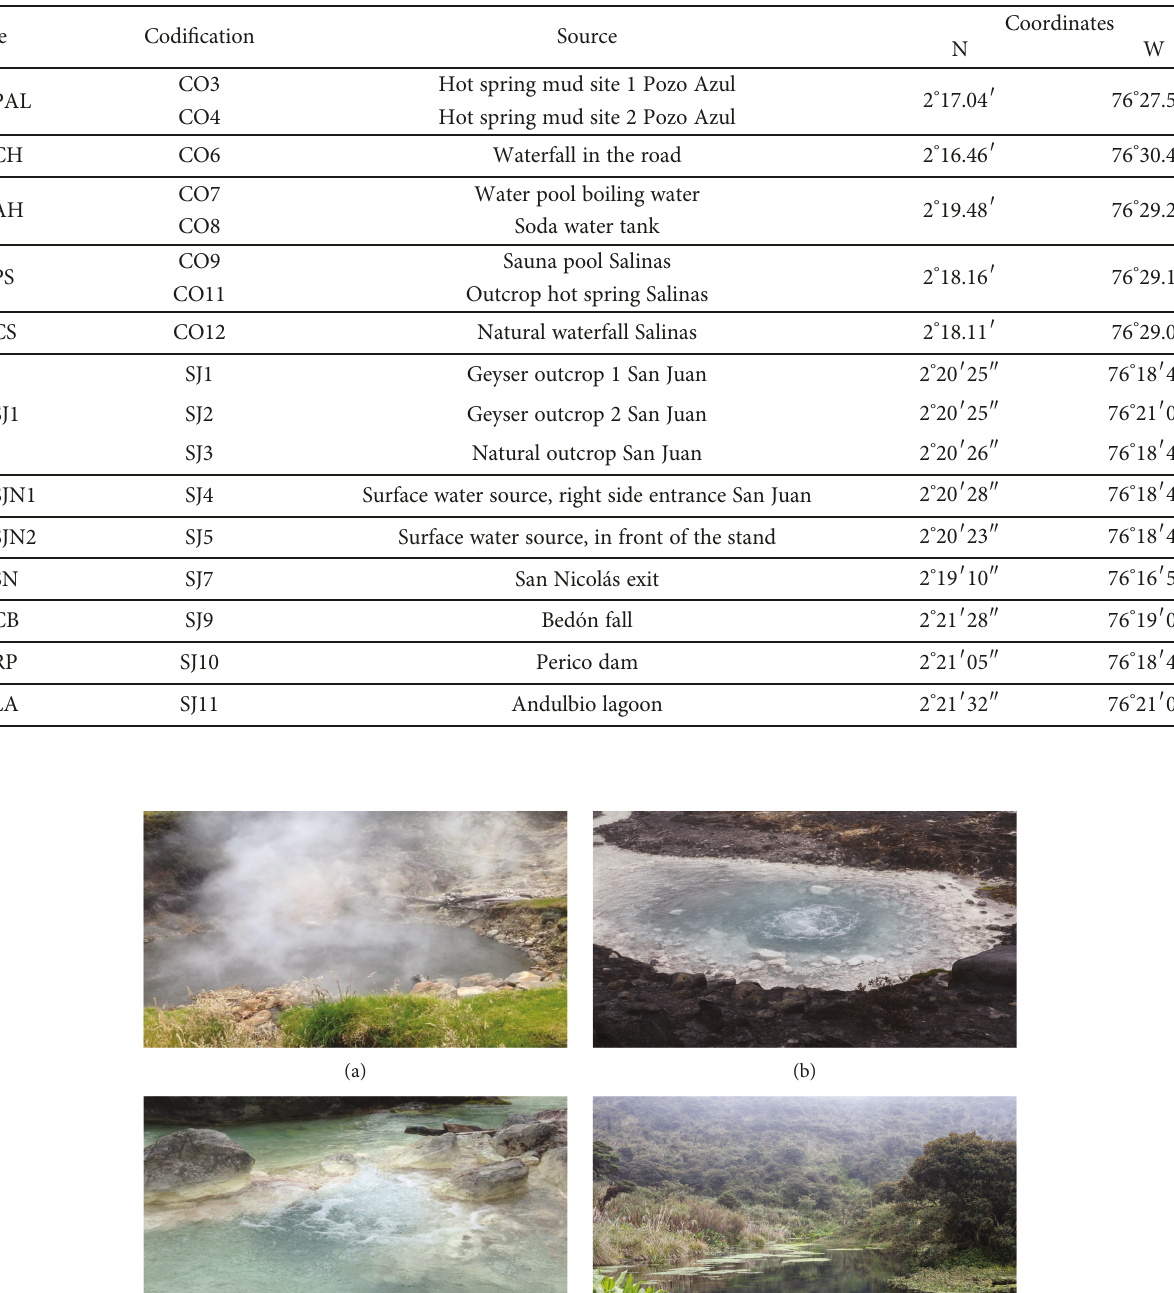
Table 1: Code, codi fi cation, coordinates, and references. Points of the Coconuco sector.